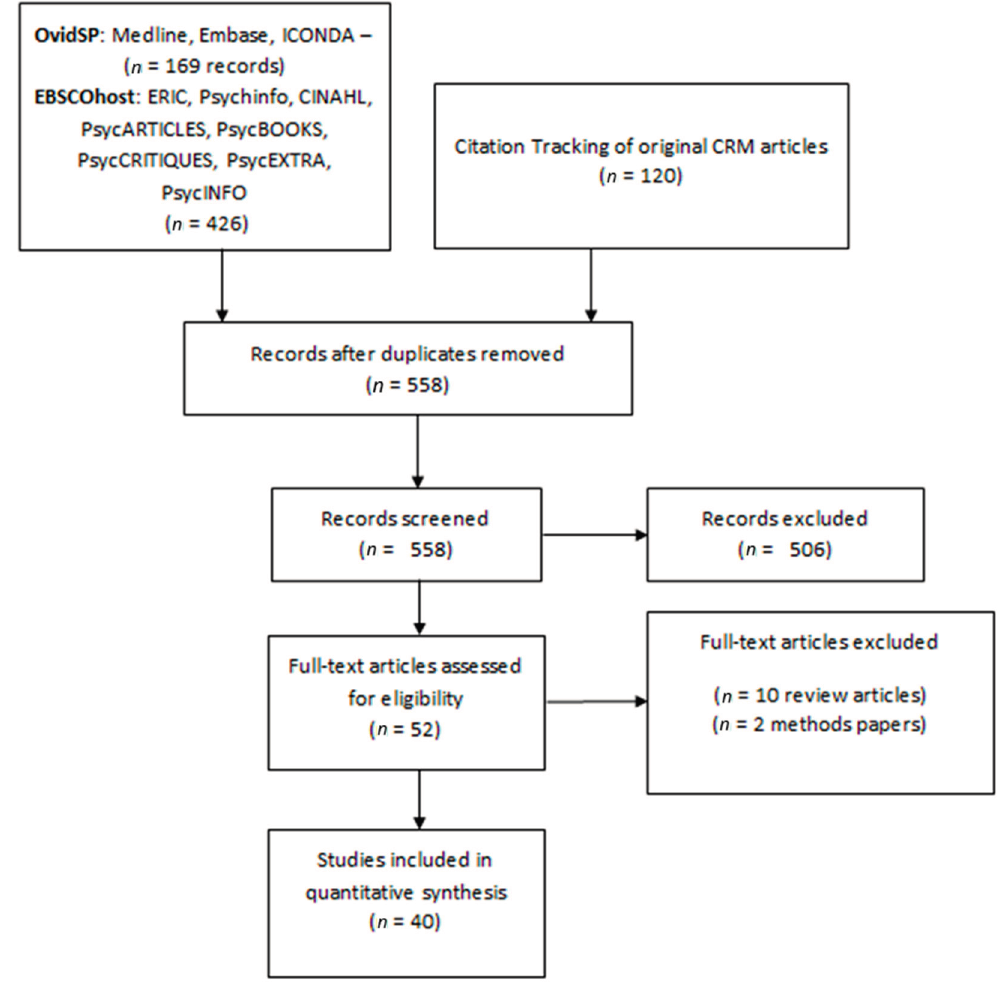
Figure 1 . PRISMA flow diagram describing the selection of studies applying the Community Readiness